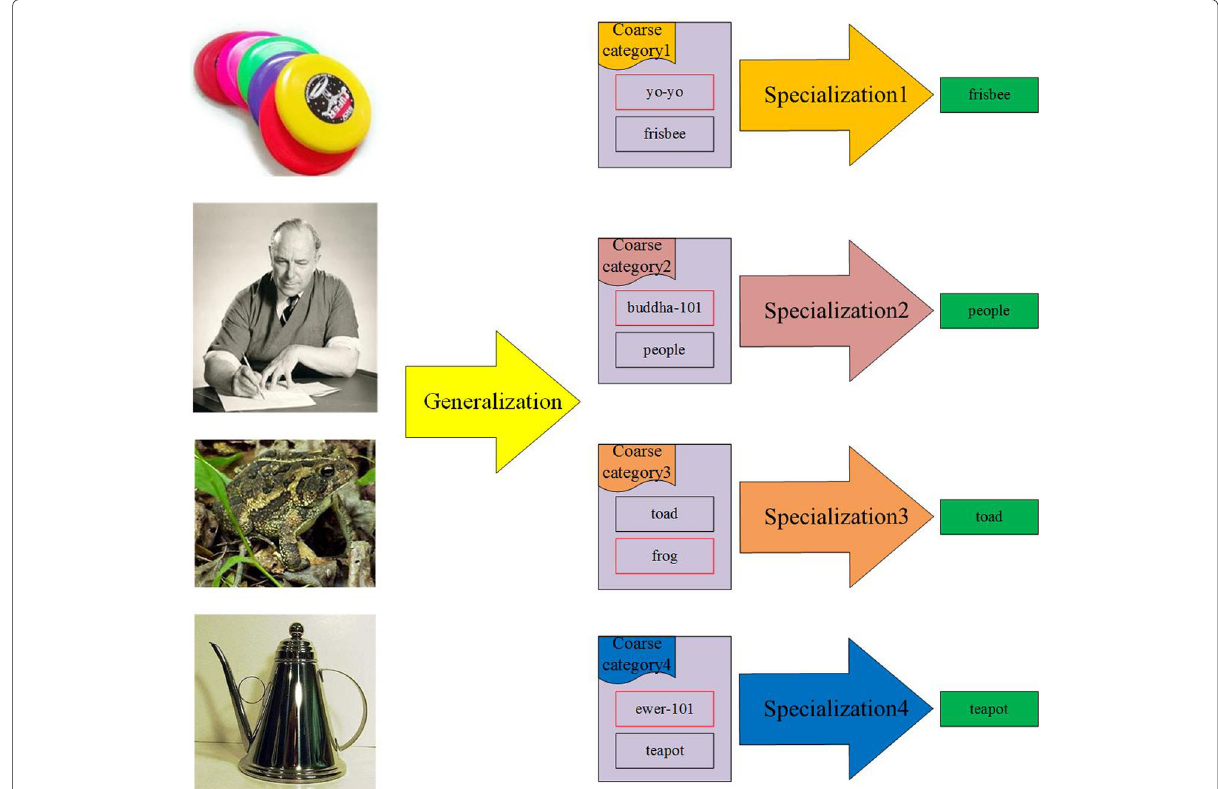
Fig. 9 Some images in Caltech256 were misclassified by the Trunk-CNN and corrected by Branch-CNNs. The red box in Coarse categories represents the output of the fine category by Trunk-CNN. The green box represents the final output of the